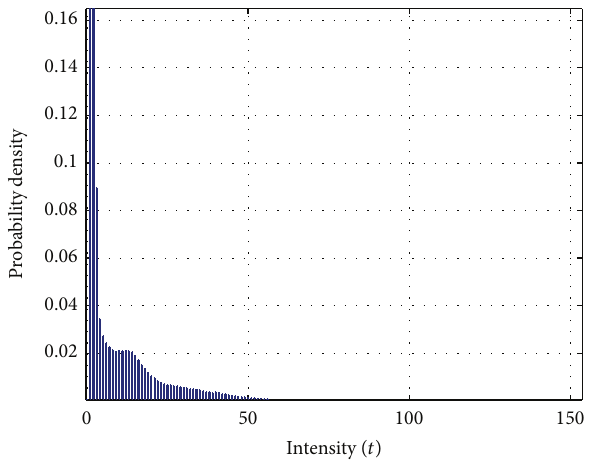
Figure 4: Histogram of the vehicle loads.